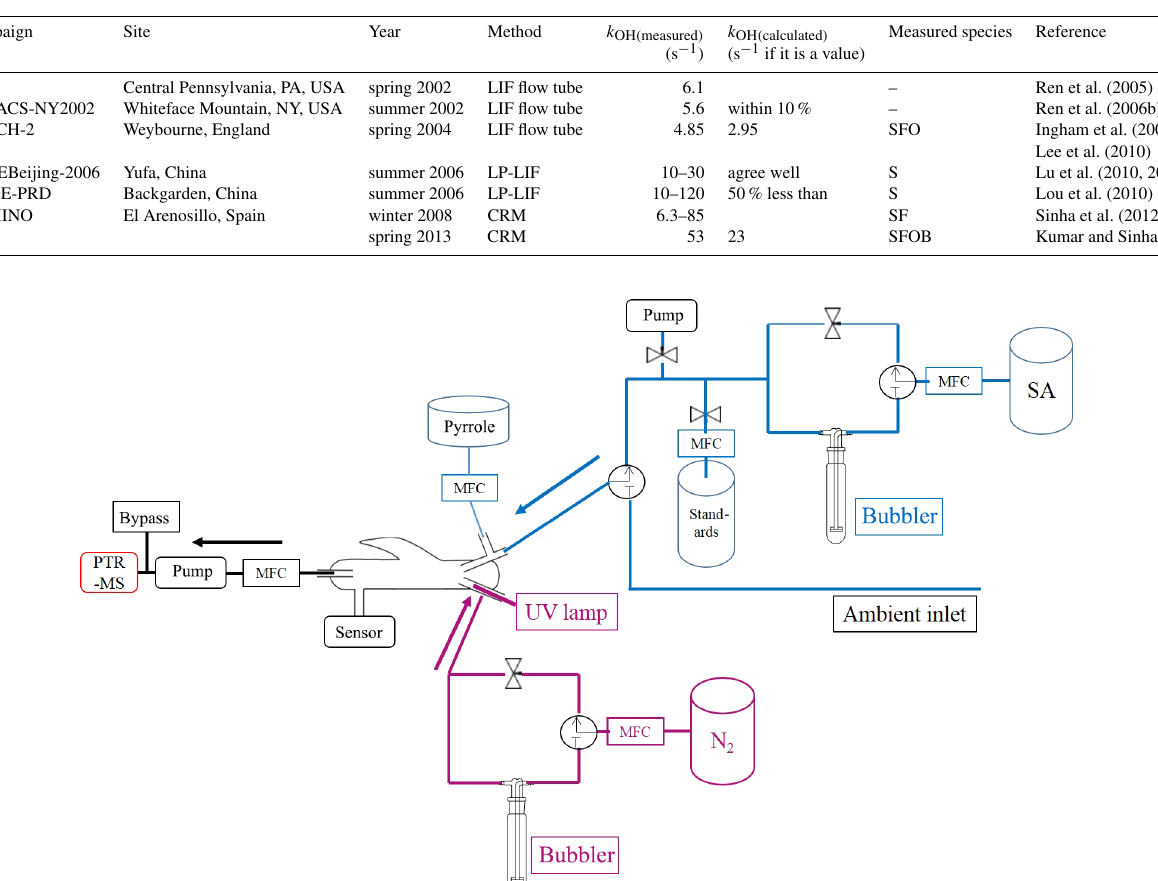
Figure 1. Schematic figures of the CRM system in Beijing and Heshan observations. The blue color represents the ambient air or synthetic air injection system; purple represents OH generating system; black represents the detection system. Pressure is measured by the sensor connected to the glass